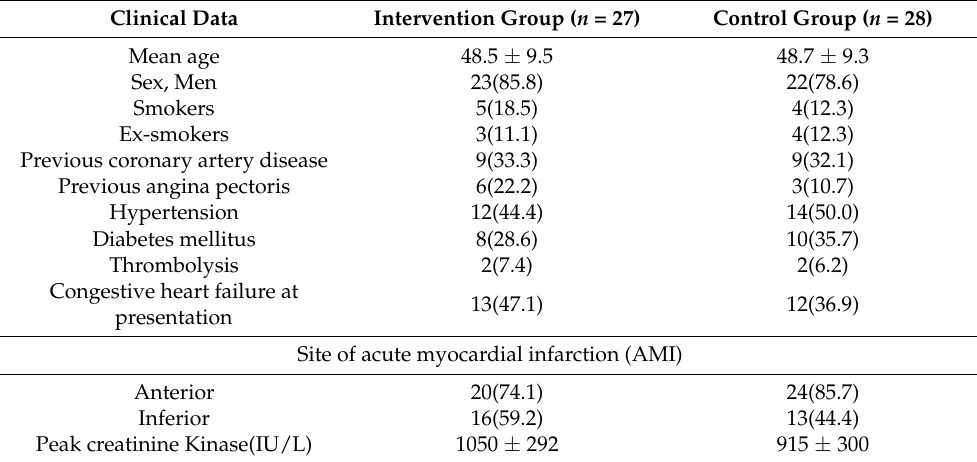
Table 2. Baseline characteristics of patients with ejection fraction <50% in the intervention and control